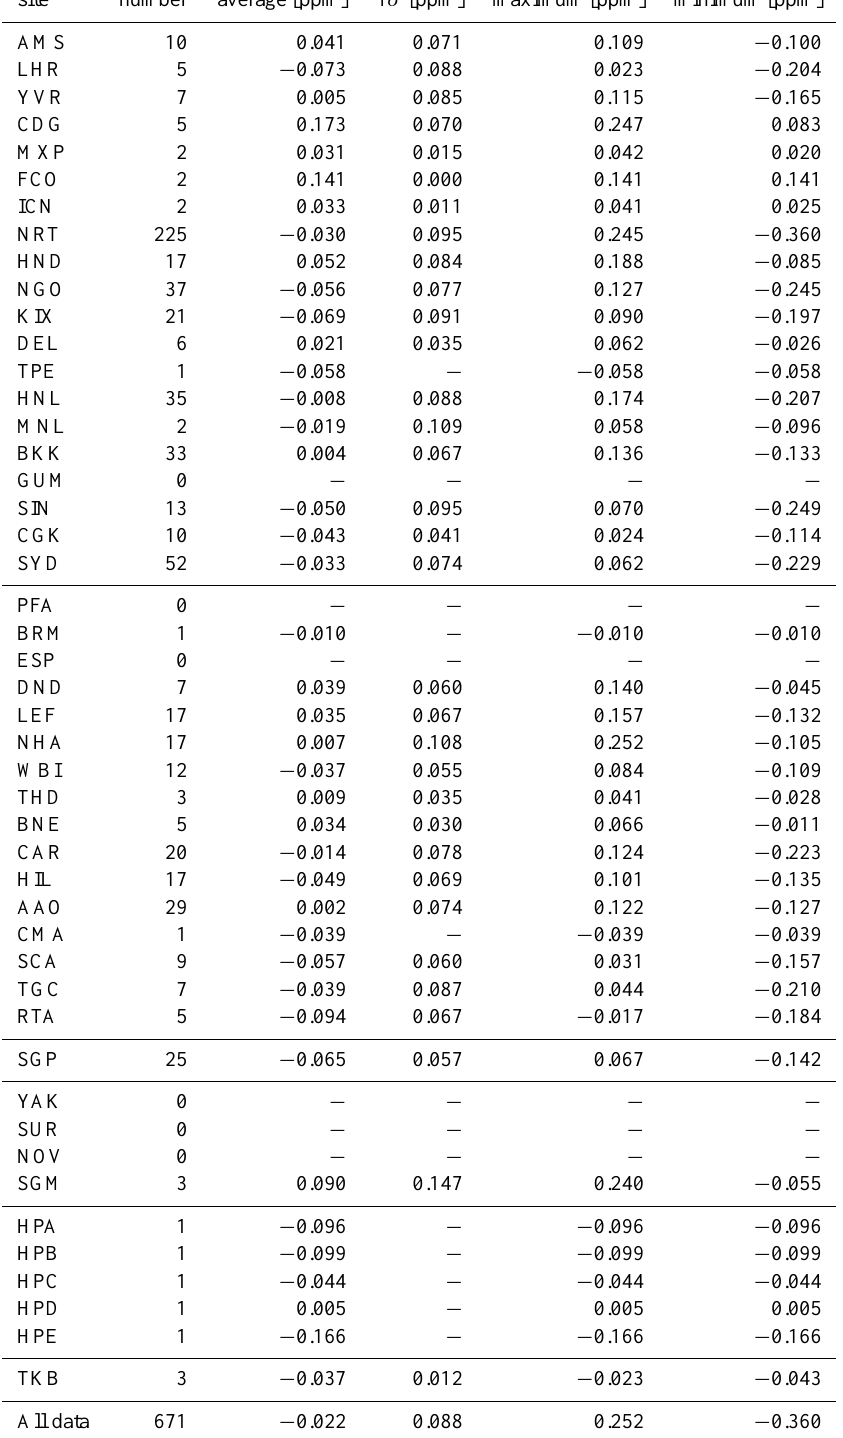
Table 2. The average, maximum, minimum, and 1 standard deviation (1 σ) of the differences between aircraft-based XCO 2 with and without the application of GOSAT CAK (aircraft-based XCO 2 with CAK minus aircraft-based XCO 2 without CAK) at each aircraft observation